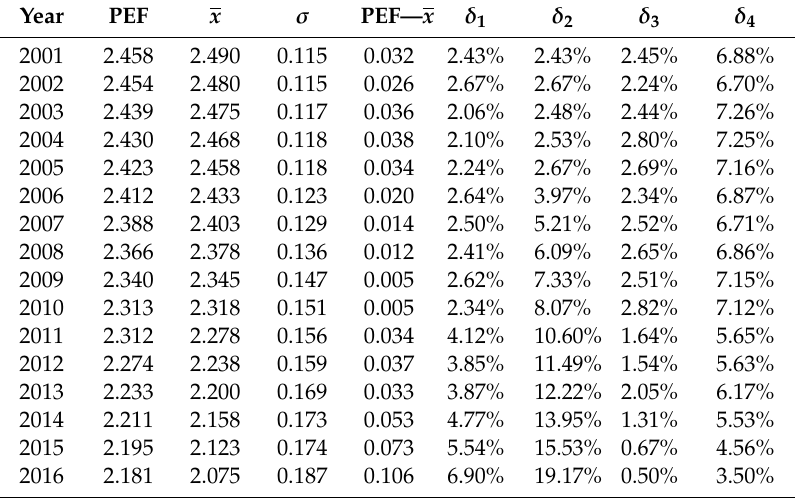
Table 4. Results of statistical verification of the original calculation method of PEF primary energy